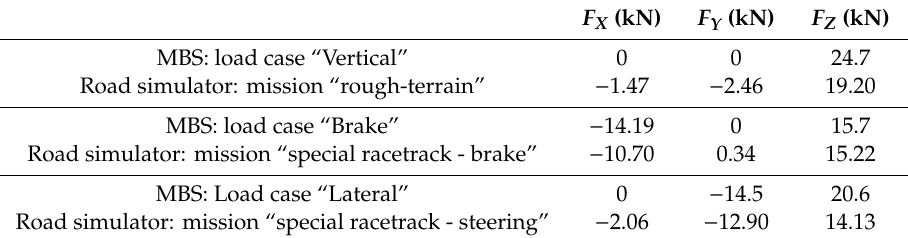
Table 3. Load cases applied in MSC / AdamsCar (MBS) and the time histories of peak loads.